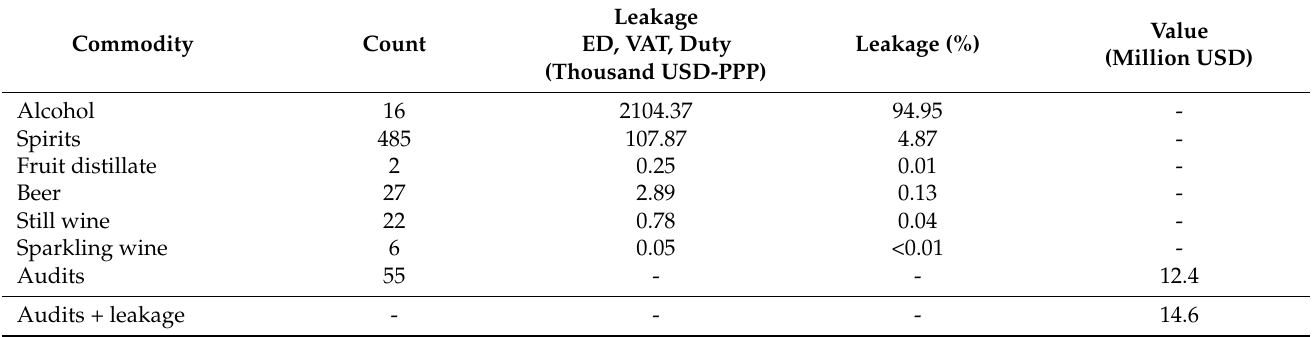
Table 11. Leakage of Excise Duty, VST, Duty related to